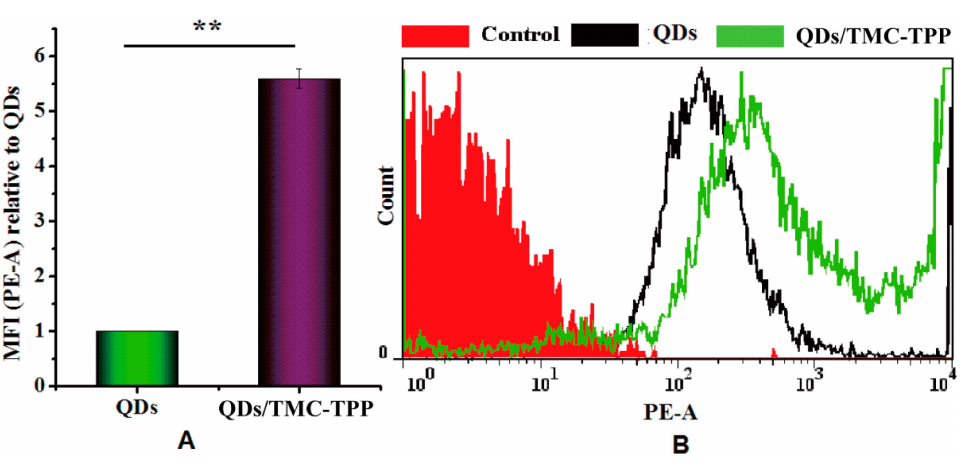
Figure 10. In vitro cell uptake by osteoblasts (OBs). OBs were exposed to soluble or nanoparticle-encapsulated QDs for 4 h and measured by flow cytometry. ( A ) Uptake expressed by mean fluorescence intensity and ( B ) Data expressed by representative overlay histogram. ** , p <